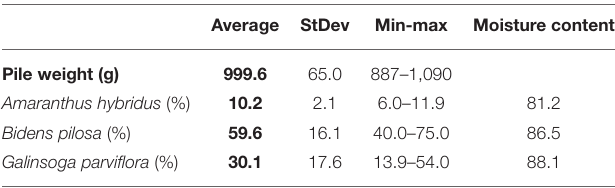
TABLE 1 | Weights in grams, percentage of each species by pile ( n = 5), and moisture content by species. Average StDev Min-max Moisture